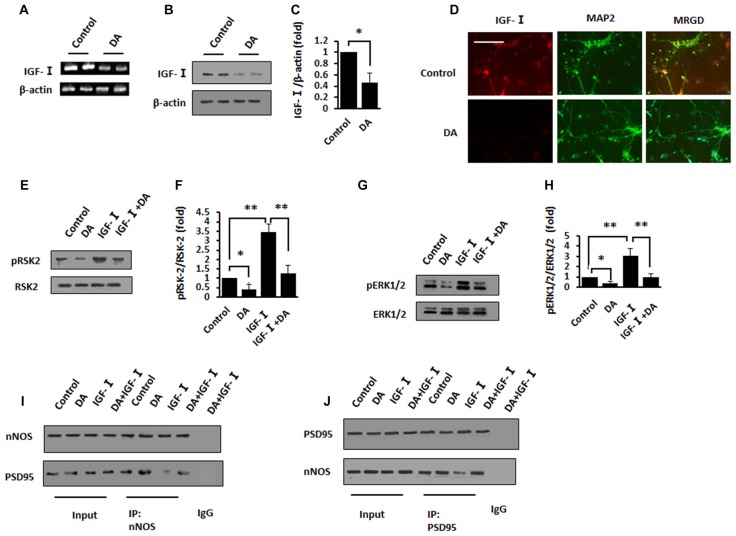
DA downregulated IGF-I to block the disruption of PSD95–nNOS interaction. (A) Assay for IGF-I mRNAs of lysates of PHNs with DA treatment for 6 h by RT-PCR. (B,C) IB analysis of lysates of PHNs with DA treatment using anti-IGF-I and anti-β-actin antibodies and subsequent densitometry. (D) Double IF staining of PHNs with DA treatment using antibodies against IGF-I (red) and MAP2 (green). (E,F) IB analysis of lysates of PHNs with or without IGF-I treatment in the absence or presence of DA using anti-pRSK and anti-RSK antibodies and subsequent densitometry. (G,H) IB analysis of lysates of PHNs with or without IGF-I treatment in the absence or presence of DA using anti-pERK1/2 and anti-ERK1/2 antibodies and subsequent densitometry. (I) Immunoprecipitation of lysates of PHNs with or without IGF-I treatment in the absence or presence of DA using control IgG and anti-nNOS antibodies. Complexes were immunoblotted with anti-PSD95/nNOS antibodies. (J) Immunoprecipitation of lysates of PHNs with or without IGF-I treatment in the absence or presence of DA using control IgG or anti-PSD95 antibodies. Complexes were immunoblotted with anti-PSD95/nNOS antibodies. Data are shown as mean ± SD. *P < 0.05, **P < 0.01. Scr, scramble. Scale bar, 25 μm. MRGD, merged image.